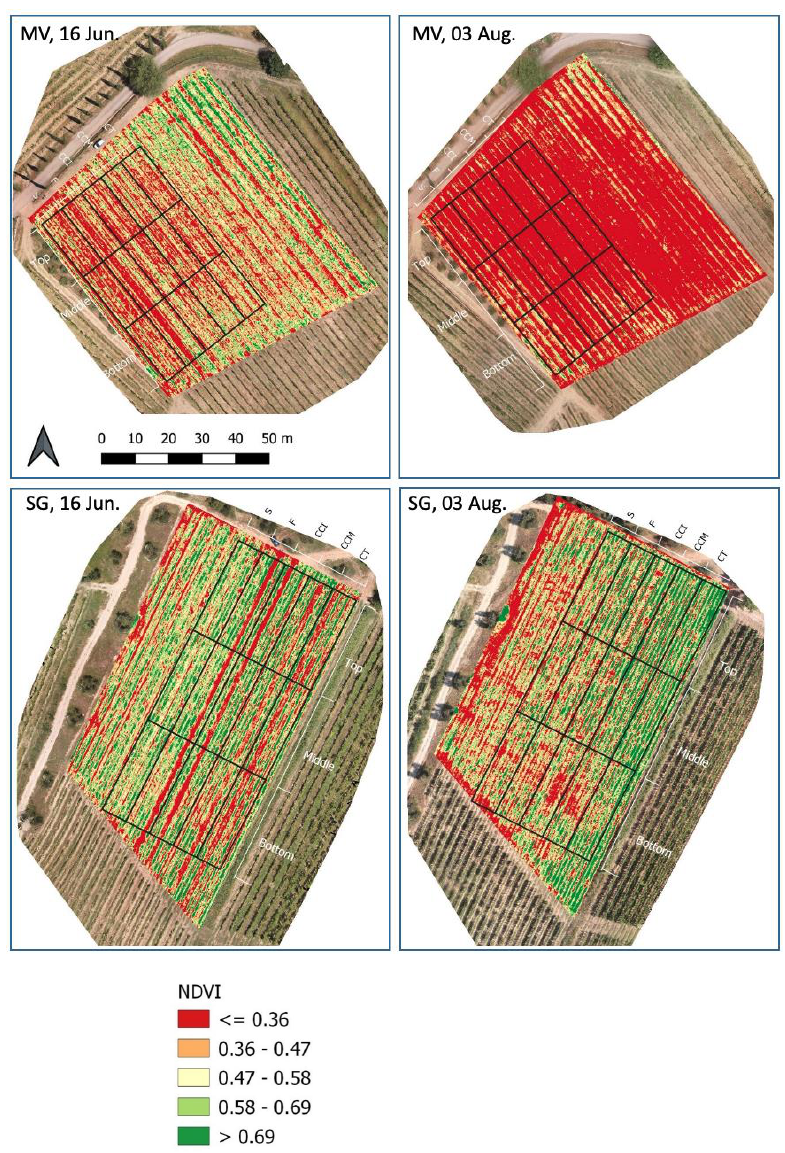
Figure 4. NDVI maps of June and August 2018 for MV and SG.